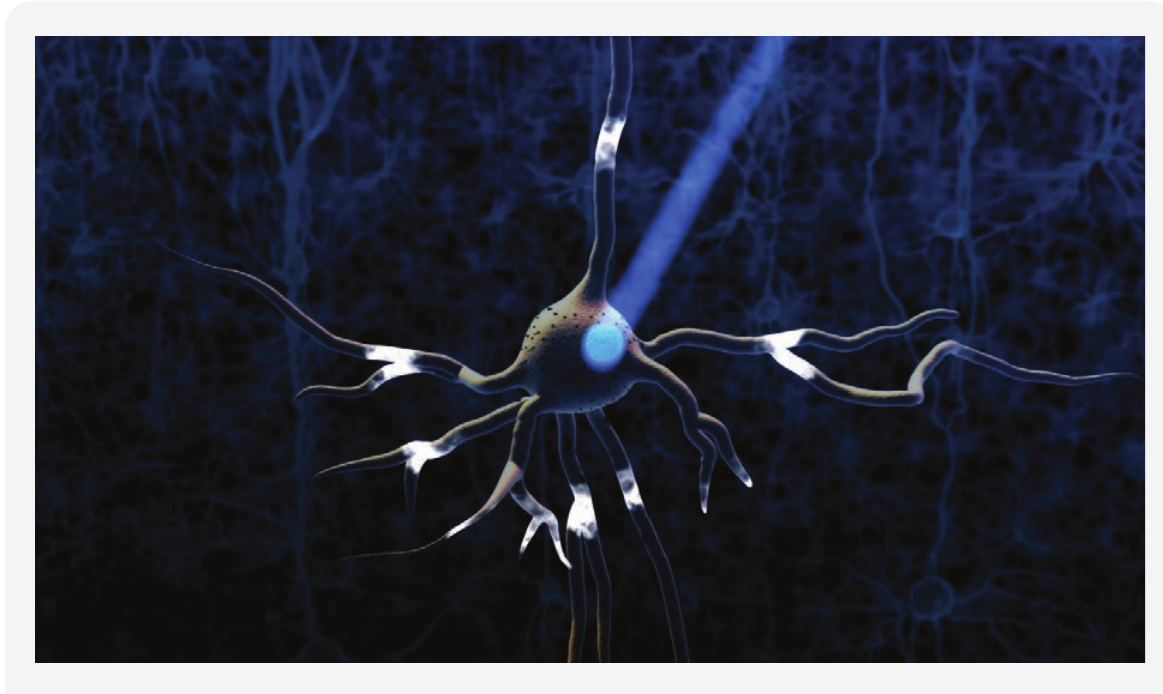
Figure 5. Cartoon of a neuron expressing channelrhodopsin-2 (small green dots) and illuminated by blue light. The light-gated ion channels open, letting positive charge into the